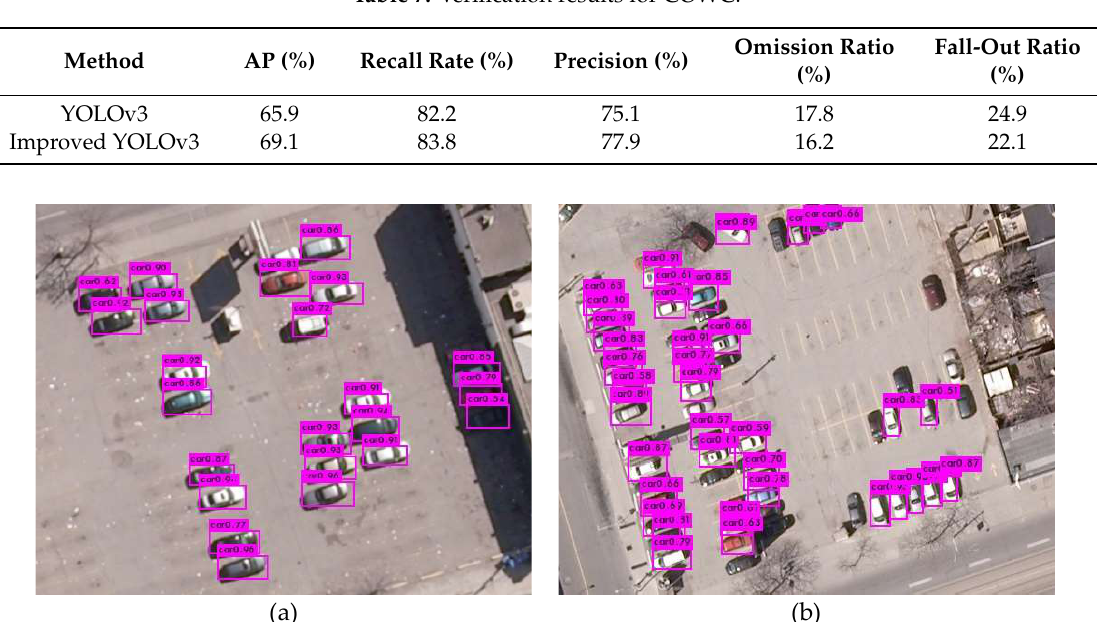
Table 7. Verification results for COWC.